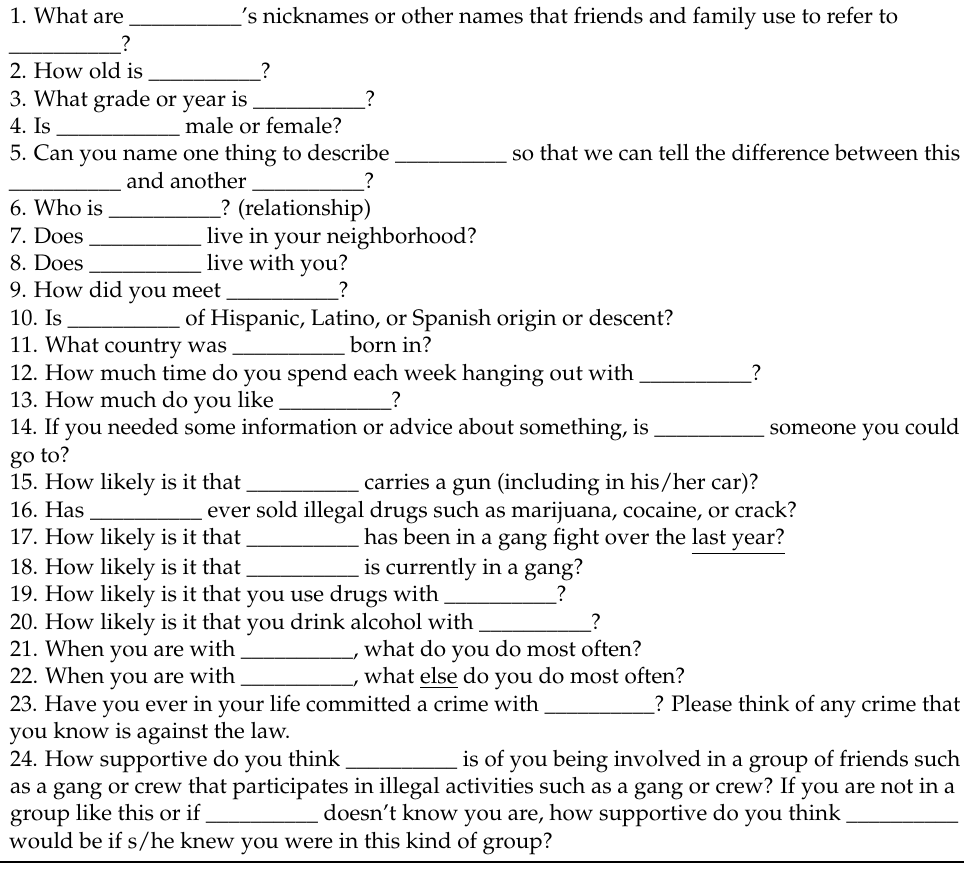
Table 1. Connect Survey Question Items about